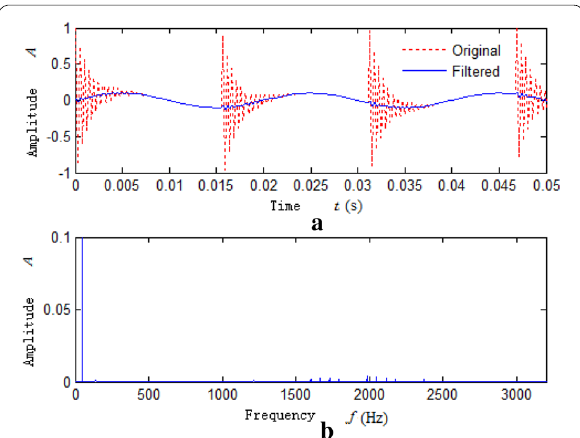
Figure 14 Filter result of the CMF: ( a ) time waveform, ( b ) FFT spectrum